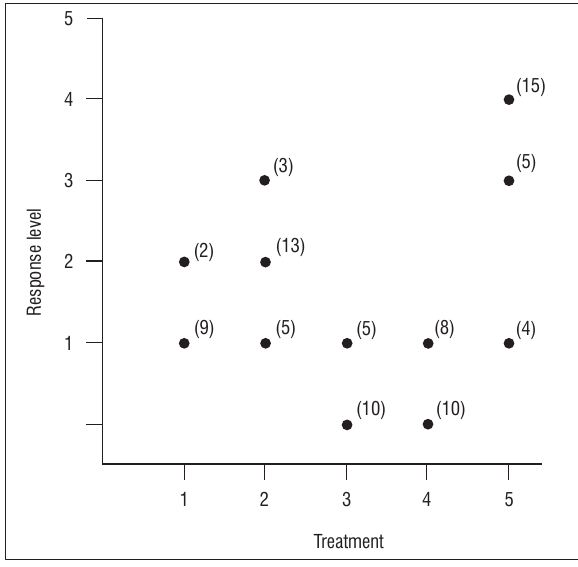
Figure 1: Elephant behavioural response level as a function of experi- mental treatment. Treatment labels are as follows: (1) control noise, (2) buzzing bee noise, (3) honey scent, (4) control noise with honey scent and (5) bee noise with honey scent. Numbers in parentheses show the sample sizes for each response level.